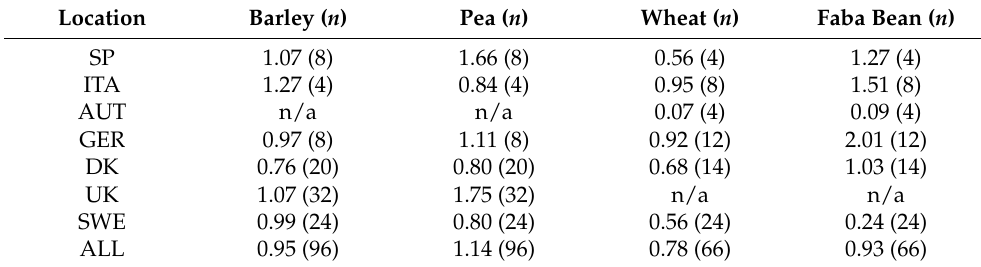
Figure 4. Regressions of single crop-based year-to-year grain yield differences for pea vs. barley ( A ), and faba bean vs. wheat ( B ) crops grown as sole crops (open symbols) and intercrops (closed symbols) in six locations across Europe in 2017 and 2018. The data from Spain were not included, see Section 2.1 for an explanation. Linear regressions: ( A ) y = − 0.419x + 0.341, R 2 = 0.12, p = 0.001, n = 88; ( B ) y = 0.232x − 0.138, R 2 = 0.02, p = 0.301, n = 62. The data points represent individual intercrop components grown as sole crops and intercrops in each of six trial locations. Table 5. Single crop-based estimates of yield stability indices calculated from adjusted coefficents of variance (aCV, %) from grain yield data assessed on barley (B) & pea (P) and wheat (W) & faba bean (F) sole crops and intercrops grown in seven locations across Europe. The stability indices were calculated as ratios between the aCV in the sole crops and the corresponding aCV when the same crop was grown as intercrop. SP Spain, ITA Italy, AUT Austria, GER Germany, DK Denmark, UK United Kingdom, SWE Sweden, ALL calculations across all sites; n indicates the number of individual cultivar combinations (plant teams) and treatments (low and high fertilization) included, for details see Table 1. n/a not applicable. Barley ( n